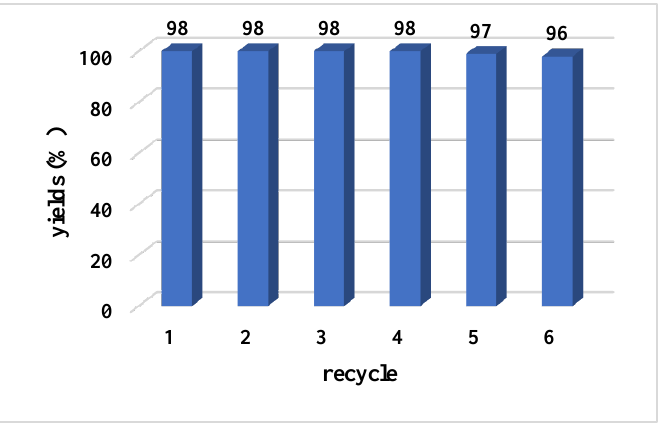
Figure 2. The recycling experiments.